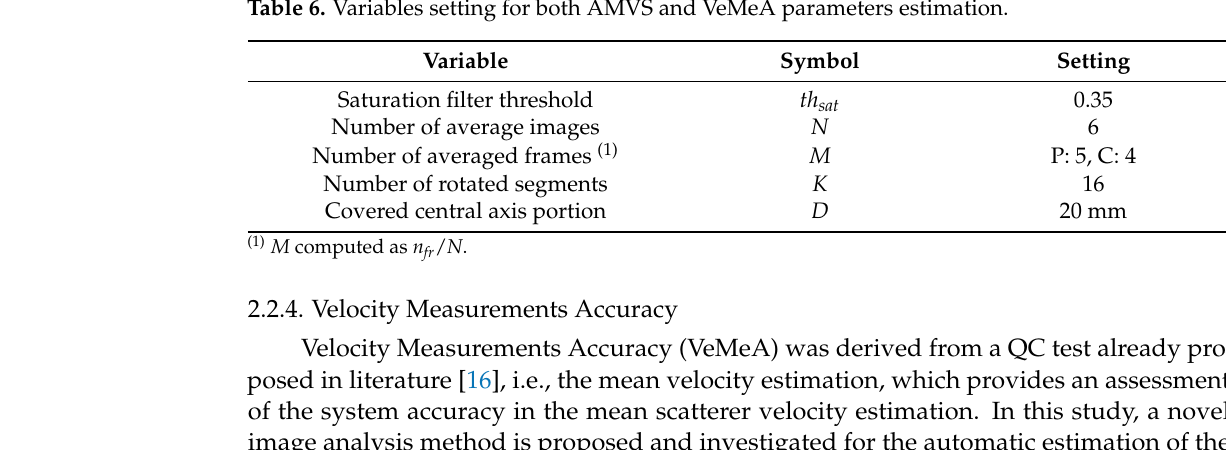
Figure 7. Example of reconstructed velocity profile associated with a single segment drawn on the i -th average image for ( a ) system one, ( b ) system two and ( c ) system three equipped with convex array probes in configuration B at 7.0 mL·s −1 .